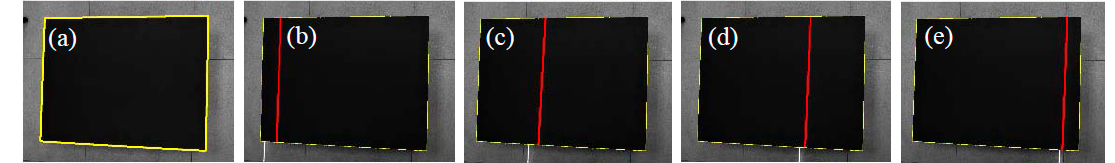
Figure 9. Images captured by the left camera: ( a ) the first image without laser stripe; ( b ) the 10th image; ( c ) the 30th image; ( d ) the 50th image; ( e ) the 70th image.